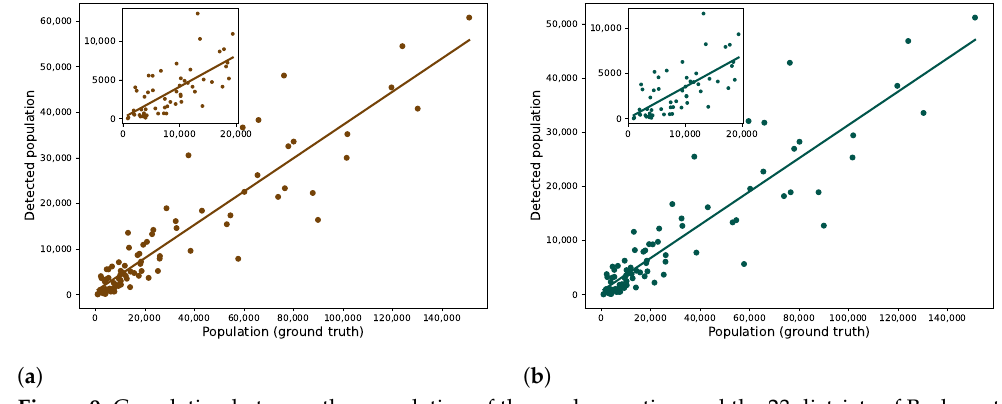
Figure 9. Correlation between the population of the agglomeration and the 23 districts of Budapest based on HCSO (ground truth) and mobile network data. The markers represent the settlements or districts (in the case of Budapest). In left figure ( a ), all the SIM cards were used, in the right figure ( b ), SIM cards that certainly operated in nonphone devices were